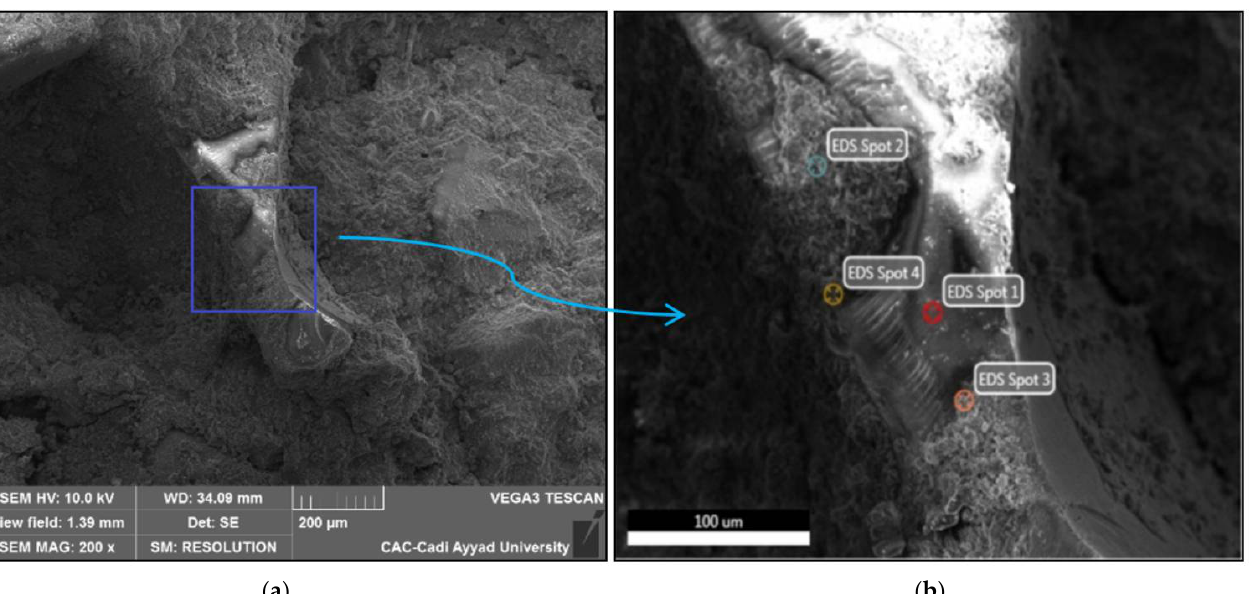
Table 5. SEM-EDS analysis of mortar incorporated with 50% volume content of RWG (MRWG50).